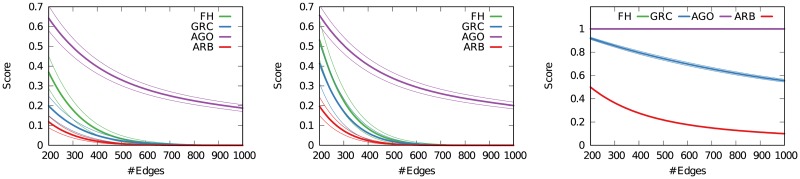
Distribution of hierarchicalness scores according to FH, GRC and arborescence for three classes of random networks for increasing number of edges (number of nodes fixed at 100).From left to right: Erdős-Rényi random graph, Watts-Strogatz small world, and directed scale free network. Average and standard deviation across 100 attempts.